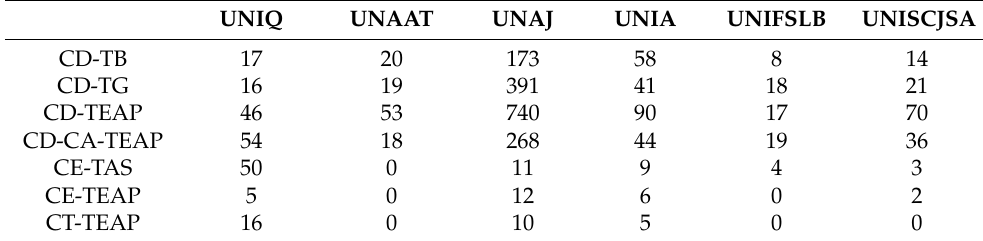
Table 5. Training distribution by university according to the type of